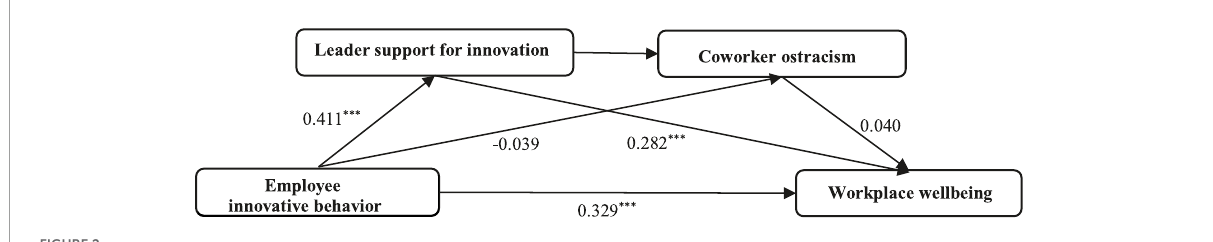
FIGURE2 Results of the theoretical model using MPLUS. N = 319, *** p < 0.001. Standardized path coefficients are reported.